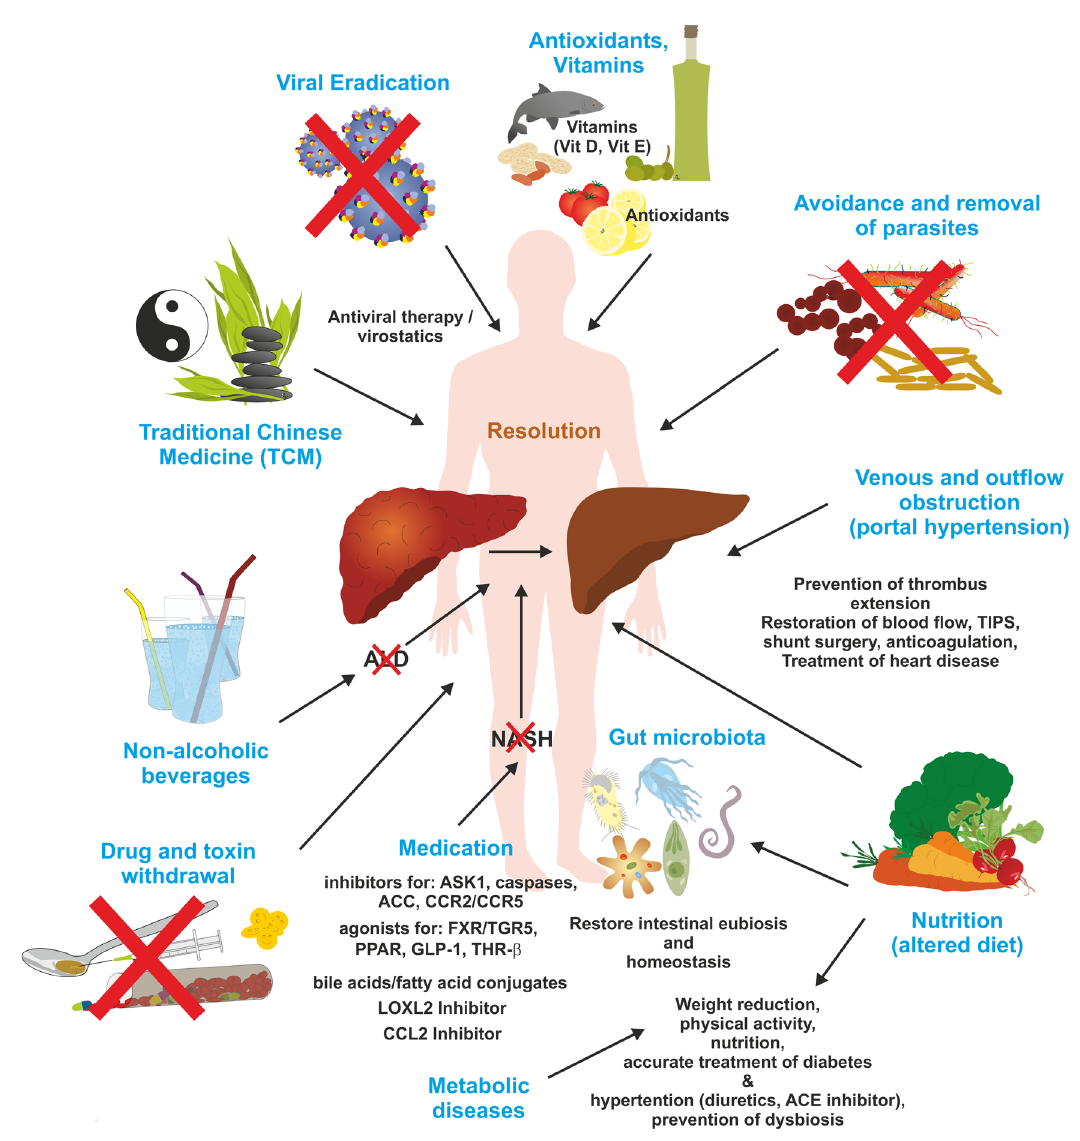
Figure 3. Strategies to induce resolution of hepatic fibrosis. Ongoing hepatic fibrosis can be haltered or resolved by specific therapies, eradication or dietary restriction of the pathogenic cause, or lifestyle and dietary interventions. In addition, several neglected features of lifestyle such as physical exercise, sun exposure, vitamin supplementation, and improved sleep duration and rhythm have been shown to be beneficial in the management of hepatic fibrosis. For more detailed explanations, see text. ACC, acetyl-CoA carboxylase; ACE, angiotensin- converting enzyme; ALD, alcoholic liver disease; ASK1, apoptosis signal-regulating kinase 1; CCL2, C-C motif chemokine ligand 2; CCR2/ CCR5, C-C motif chemokine receptor 2/5; FXR, farnesoid X receptor; GLP-1, glucagon-like peptide-1; LOXL2, lysyl oxidase-like 2; NASH, non-alcoholic steatohepatitis; PPAR, peroxisome proliferator-activated receptor; TGR5, G-protein-coupled membrane receptor 5; THR- β , thyroid hormone receptor- β ; TIPS, transjugular intrahepatic portosystemic shunt.